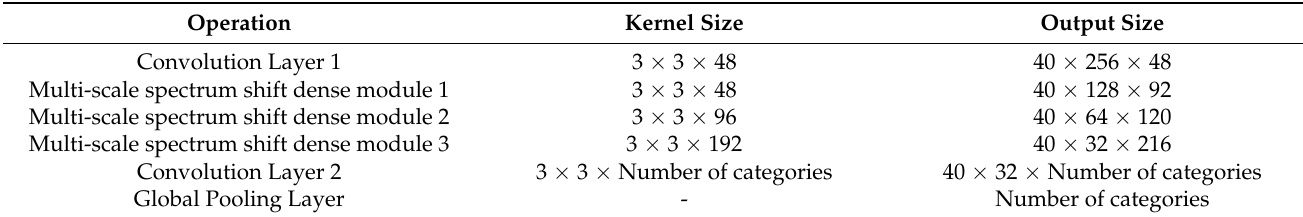
Table 1. Overall network